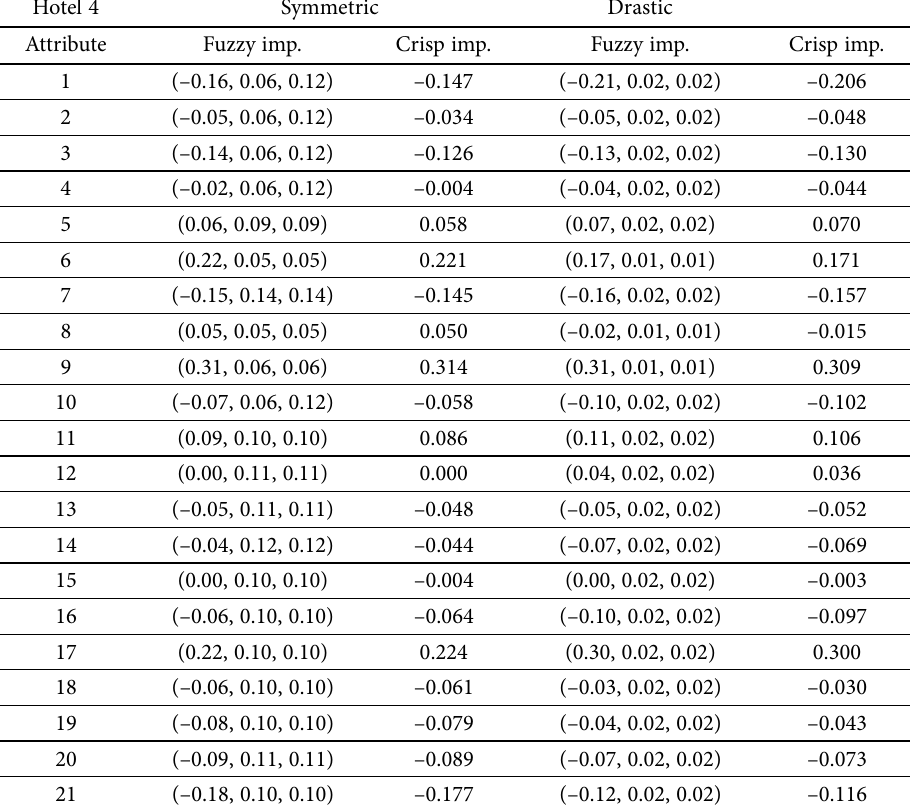
Table 9. Fuzzy importance and crisp importance of attributes – Hotel